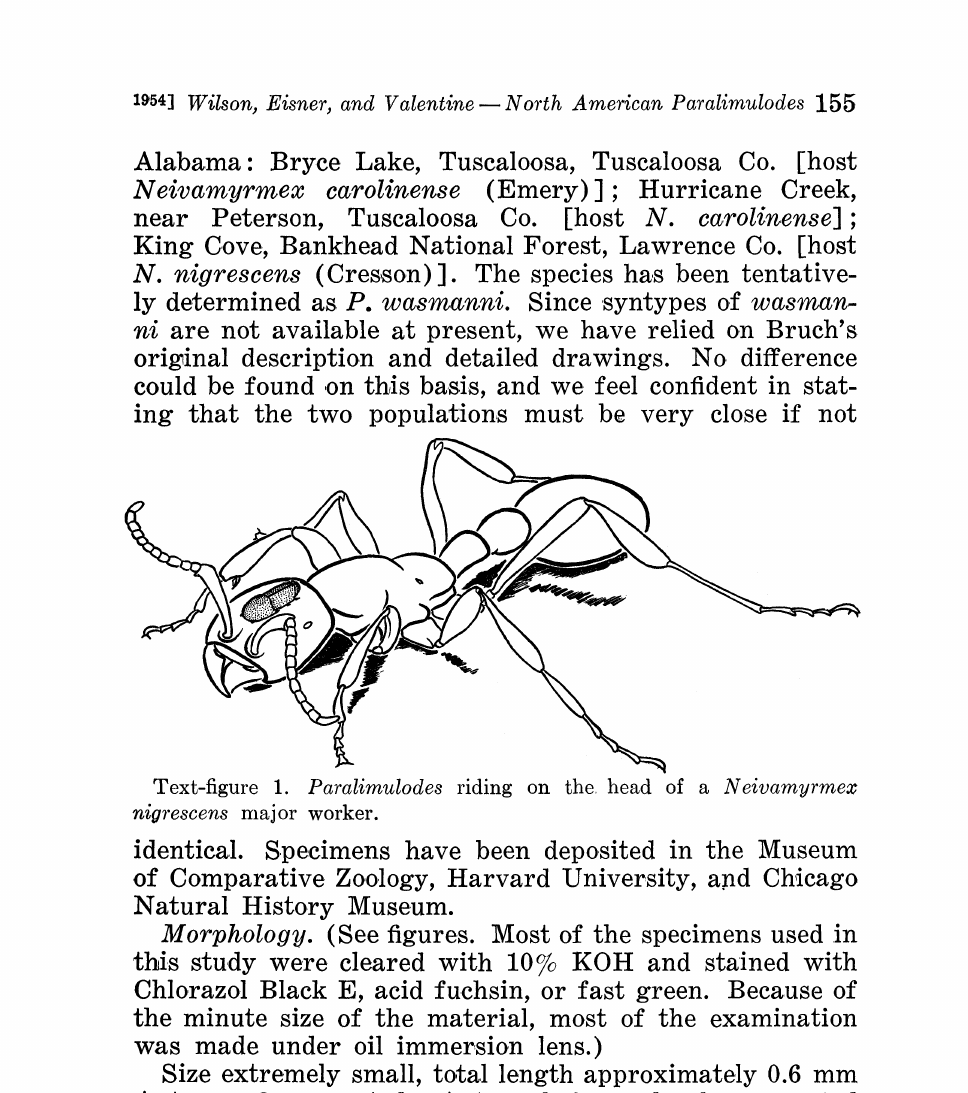
Text-figure 1. Paralimulodes riding on the. head of a Neivamyrmex nigrescens major